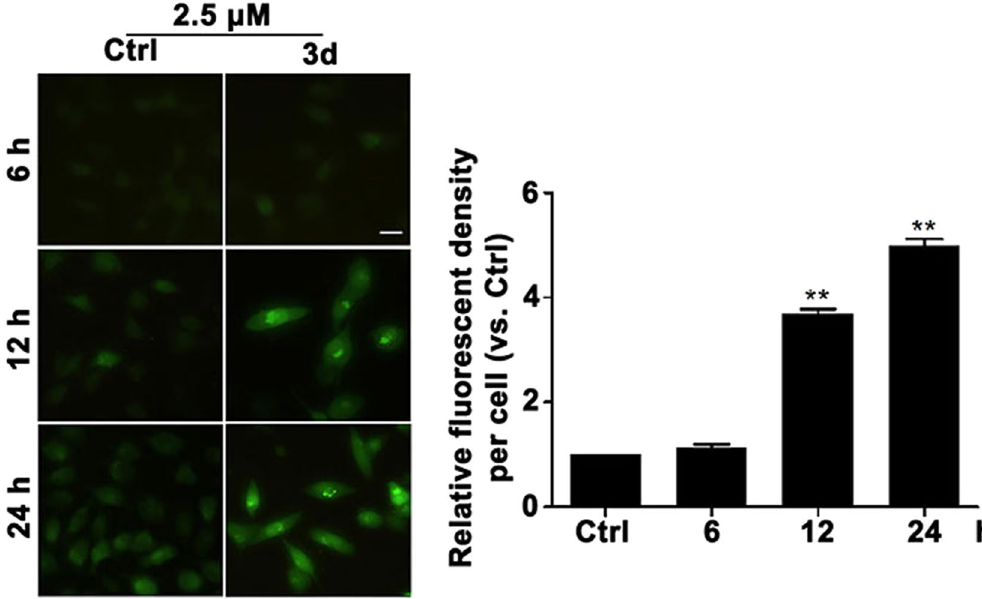
Figure 4. Compound 3d increased the level of ROS in A549 lung cancer cells. The level of ROS was detected after the cells were treated with compound 3d at 2.5 μ M for 6 h, 12 h and 24 h (magnification 200 × ). Fluorescent image of A549 cells stained by DCHF-DA. Fluorescence quantitative statistics. Scale bar: 10 μ m. Data are mean ± SEM ( ** p < 0.01 vs. control. N =